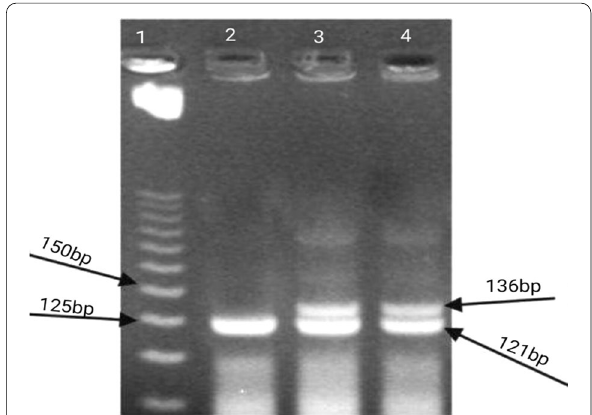
Fig. 1 IL‑6 ( 174 G/C) PCR products of three samples. Lane (1) 25 bp − ladder, sample 1 in lane (2) GG genotype, sample 2 in lane (3) GC genotype and sample 3 in lane (4) GC genotype